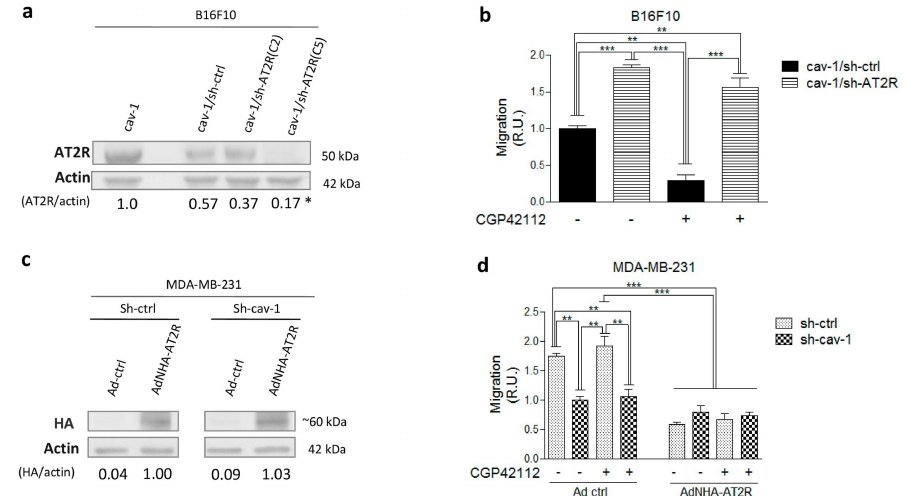
Figure 2. Depletion of angiotensin II type-2 receptor (AT2R) enhances B16F10(cav-1) cell migration, while AT2R overexpression abrogates MDA-MB-231 cell migration. ( a ) B16F10(cav-1) cells were transfected with a short hairpin AT2R (shAT2R) RNA-encoding vector to obtain B16F10(cav-1 / sh-AT2R) cells. The clones with less AT2R expression (clon 2) and (clon 5) were compared with B16F10(cav-1 / sh-ctrl) and B16F10(cav-1) by immunoblotting using antibodies against AT2R, caveolin-1 (CAV1), and β -actin. The numbers below individual lanes show the average values for AT2R / actin ratios normalized to B16F10(cav-1) (N = 3). B16F10(cav-1) (1.0 ± 0.16), B16F10(cav-1 / sh-ctrl) (0.57 ± 0.08), B16F10(cav-1 / sh-AT2R) clon 2 (C2) (0.37 ± 0.05), and B16F10(cav-1 / sh-AT2R) clon 5 (C5) (0.17 ± 0.02). ( b ) Migration of B16F10(cav-1 / sh -AT2R) clon 5 pretreated for 30 min with the AT2R agonist N- α -Nicotinoyl-Tyr-Lys-(N- α -Z-Arg)-His-Pro-Ile (CGP42112; 1 µ M) was evaluated as described. ( c ) MDA-MB-231 cells transduced with AdNHA-AT2R or Ad-ctrl adenoviral were analyzed by immunoblotting with antibodies against the hemagglutinin (HA) tag and β -actin (N = 1). ( d ) Migration of transduced MDA-MB-231, pretreated for 30 min with CGP42112 (1 µ M), was evaluated as described. The graphs show values normalized to the average of the control condition (N = 3) (mean ± standard error of mean). Results obtained were compared statistically as explained in Materials and Methods. Significant differences are indicated as *** p ≤ 0.001, ** p ≤ 0.01, and * p ≤ 0.05. (R.U., relative